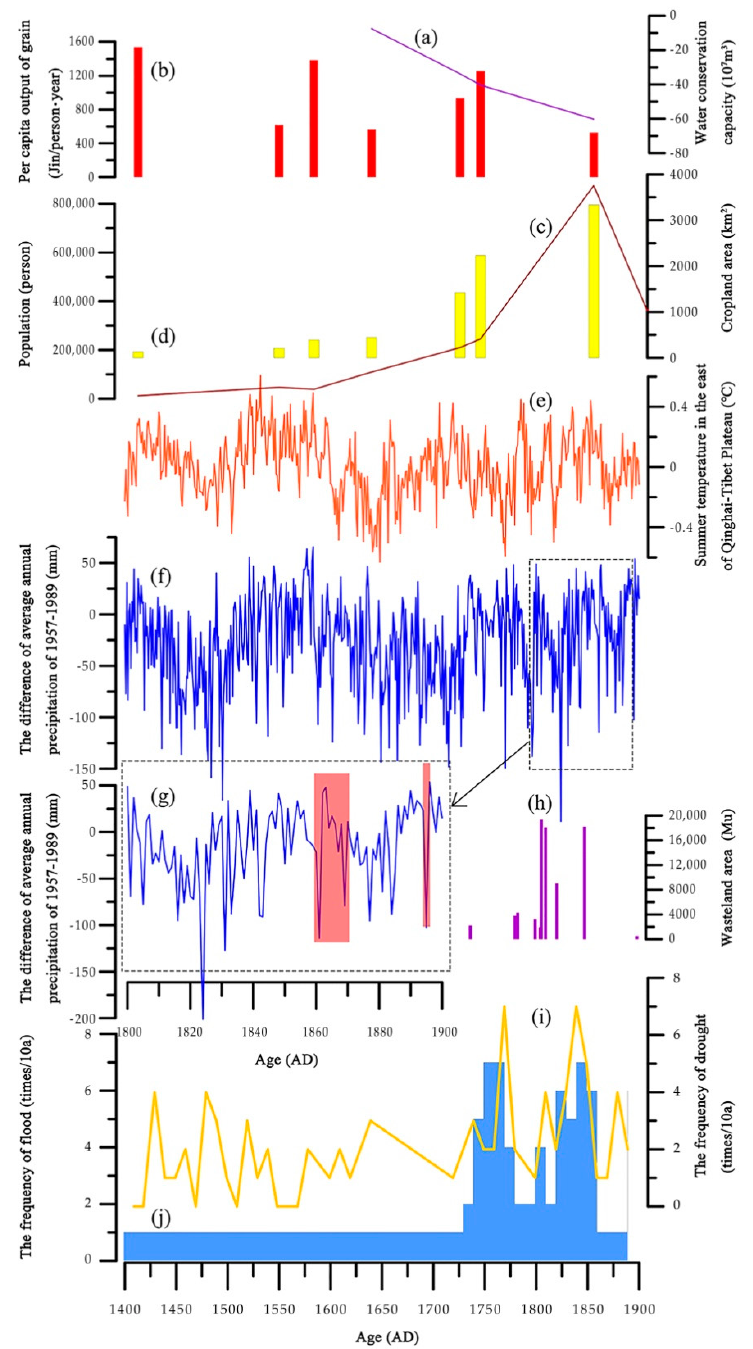
Figure 6. Comparison of water conservation capacity with climate, natural disasters, and social indicators intheHehuang valley during the Ming and Qing Dynasties. Note: ( a ) Water conservation capacity (this study), ( b ) Per capita output of grain (this study), ( c ) Population [12,14,15], ( d ) Cropland area [12,14,15], ( e ) Summer temperature in the east of Qinghai–Tibet Plateau [34], ( f ) 1400–1900AD precipitation variation [22], ( g ) 1800–1900 ADprecipitation variation [22], ( h ) Wasteland area [26], ( i ) The frequency of drought [33], and ( j ) The frequency of flood